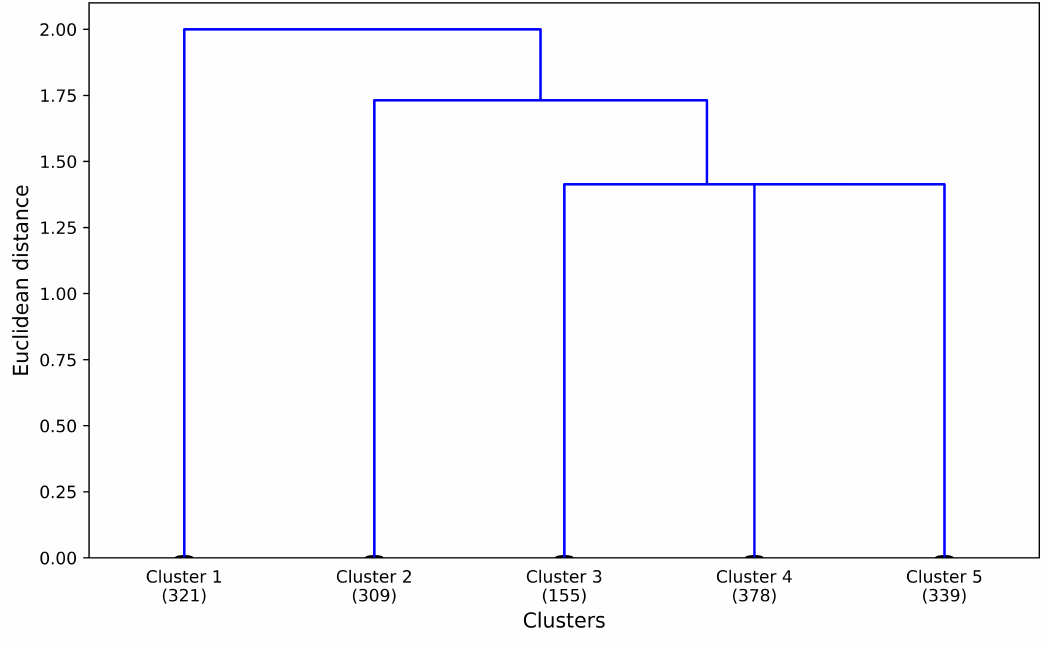
Figure 4. Tourist segments in